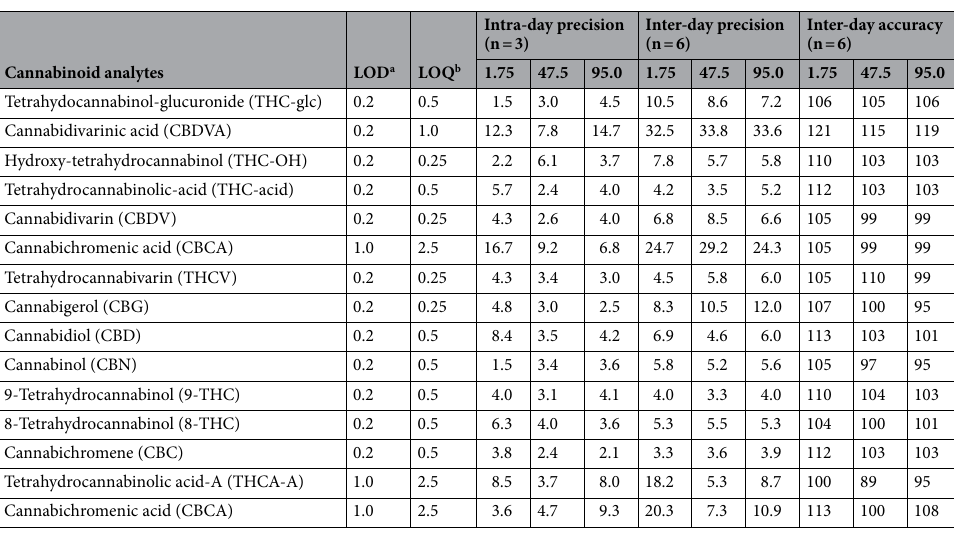
Table 6. Lower level of detection (LOD), lower limit of quantification (LOQ), intra-day precisions, inter-day precisions, and inter-day accuracies for each cannabinoid analyte analyzed following oral administration of industrial hemp. a LOD lower limit of detection. b LOQ lower limit of